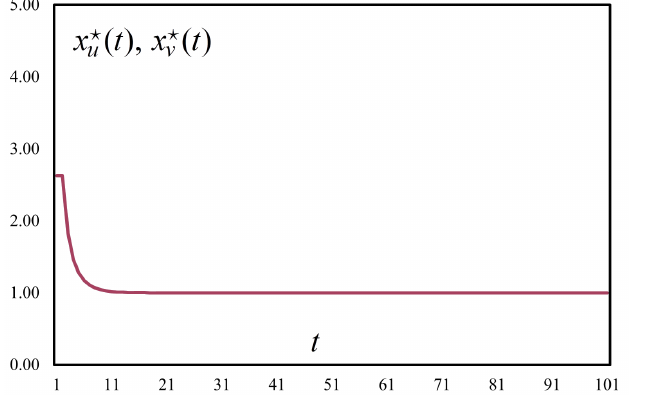
Figure 3. Convergence dynamics of Nash allocations ( x (cid:63) u , x (cid:63) v ) for α = 0.50. The x -axis corresponds to the timeline ( t ). The y -axis denotes the evolution of Nash allocations as a function of time ( x (cid:63) u ( t ) , x (cid:63) v ( t ) ).